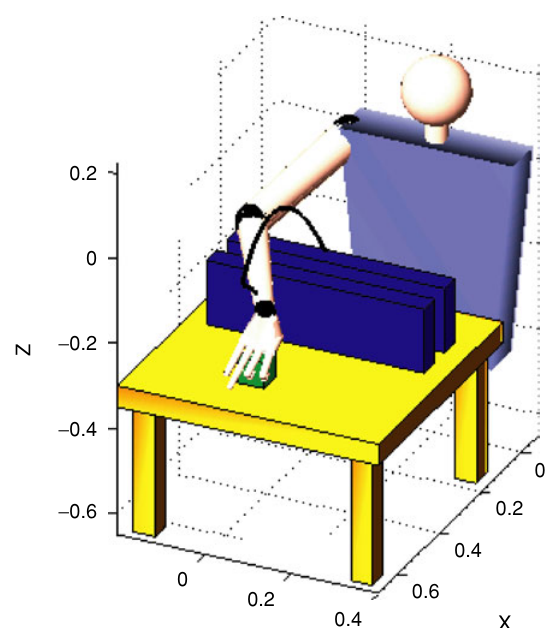
Figure 18 Simulated trajectory.